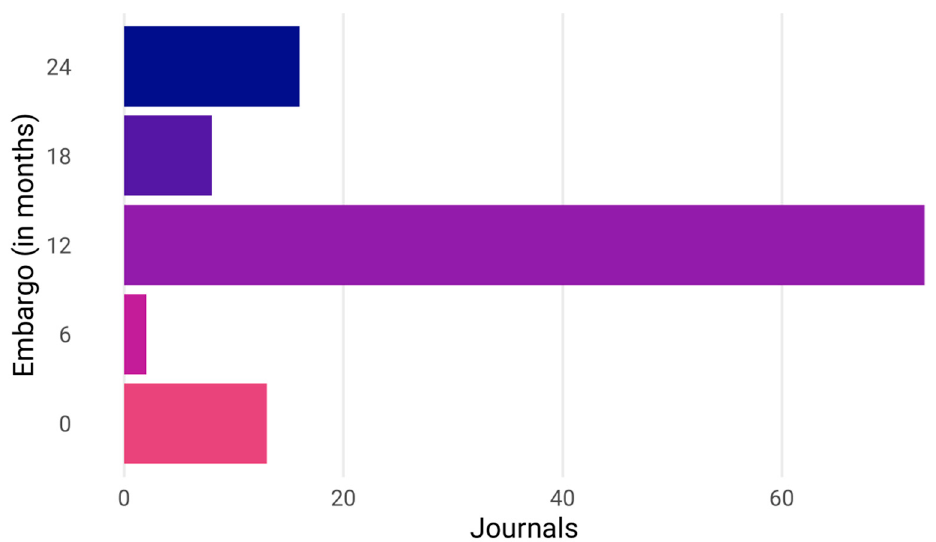
Figure 15. Embargo periods for self-archiving imposed by reverse-flip hybrid OA journals (accepted manuscript on a personal webpage or in an institutional or subject repository).